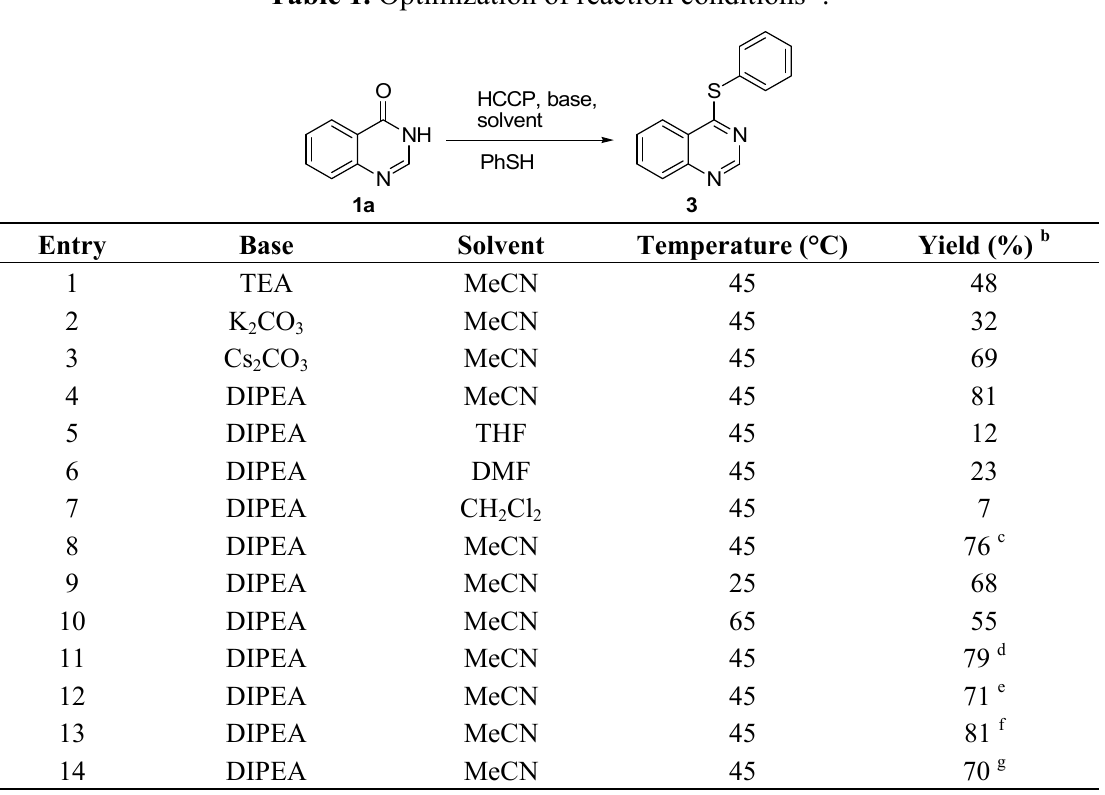
Table 1. Optimization of reaction conditions a